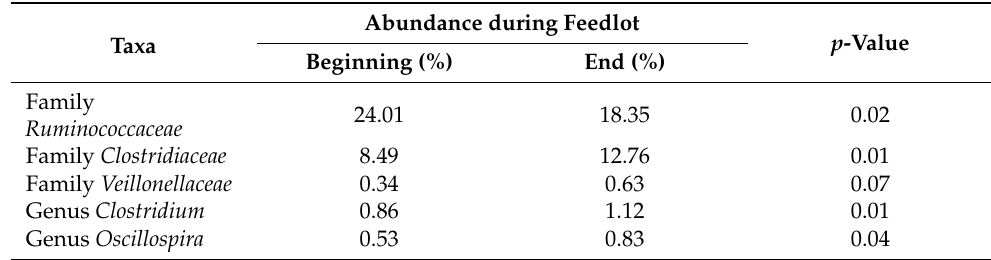
Table 2. Summary of all bacterial taxa found to be significantly changed (or with tendency to change) in the less efficient (High RFI) steers from beginning to end of the feedlot period. Taxa